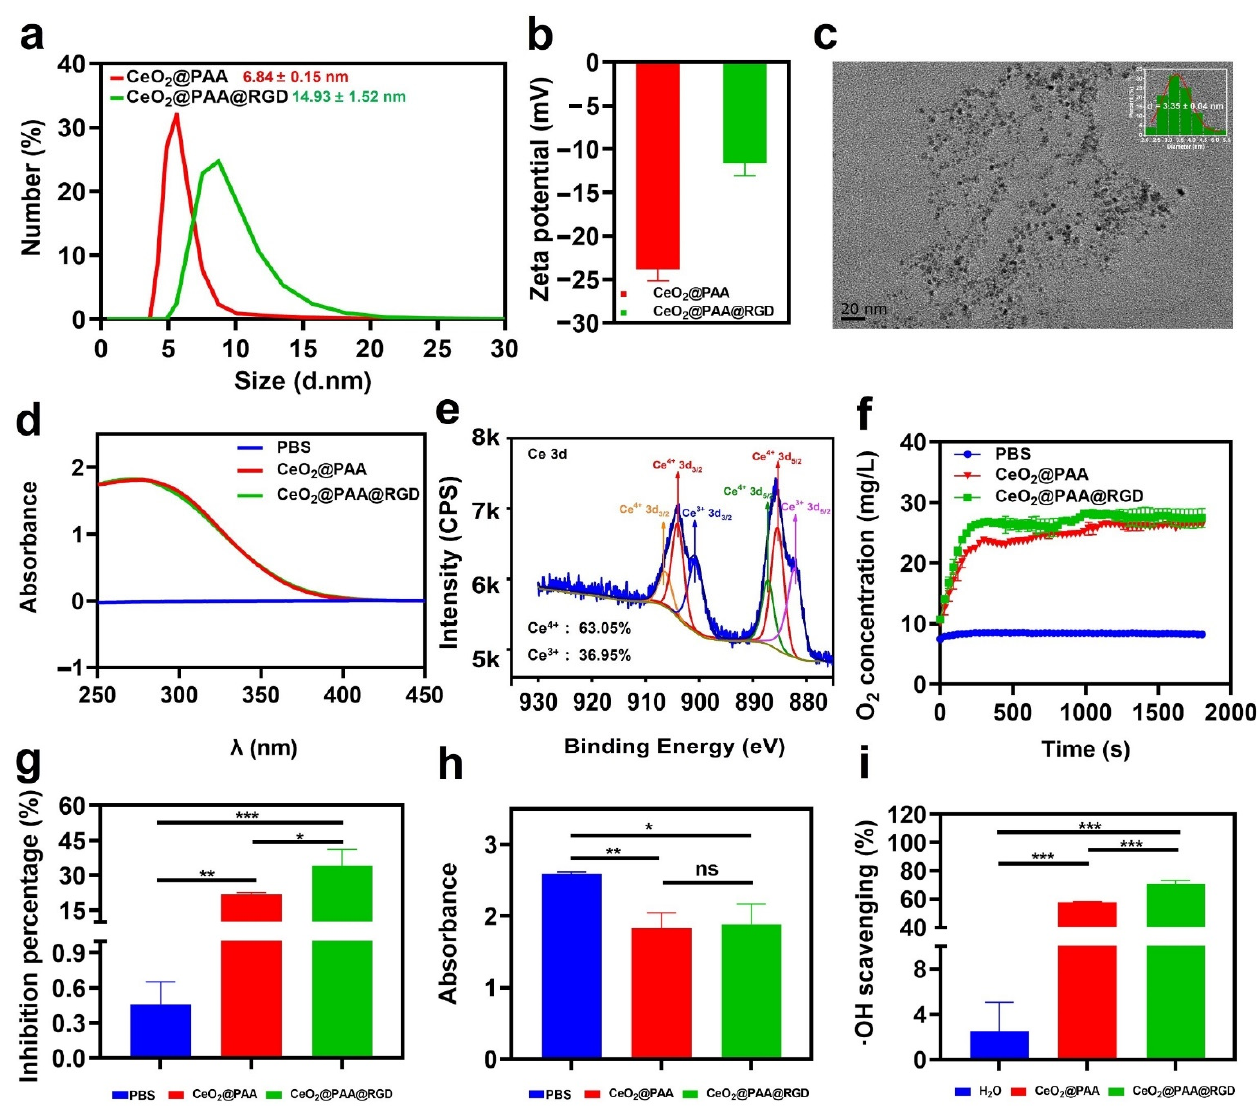
Figure 1. In vitro physicochemical characterizations, enzymatic activity, and ROS-scavenging